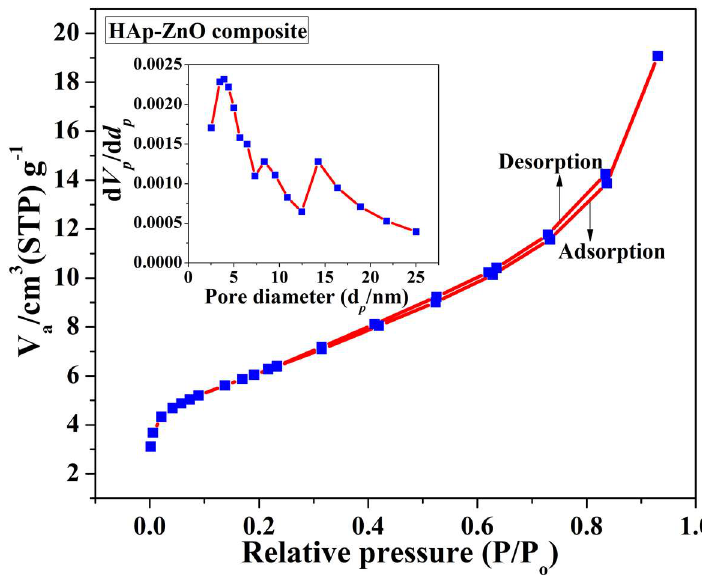
Figure 4. N 2 adsorption–desorption isotherm of HAp-ZnO composite.